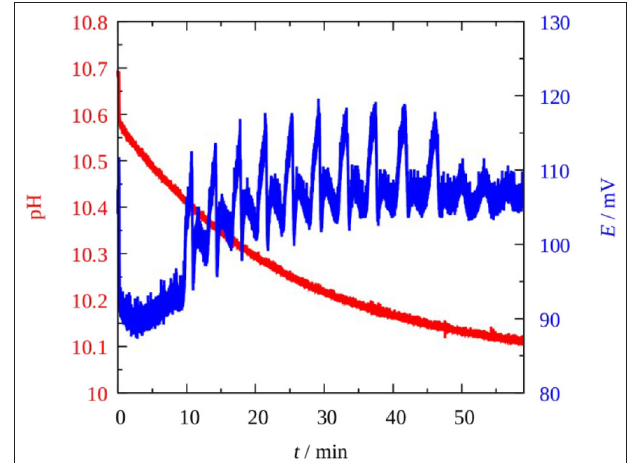
FIGURE 1 | pH (red) and potential oscillations in the Pt vs. SCE electrode pair (blue) in the Cu 2 + -catalyzed sodium perborate–sodium thiosulfate CSTR